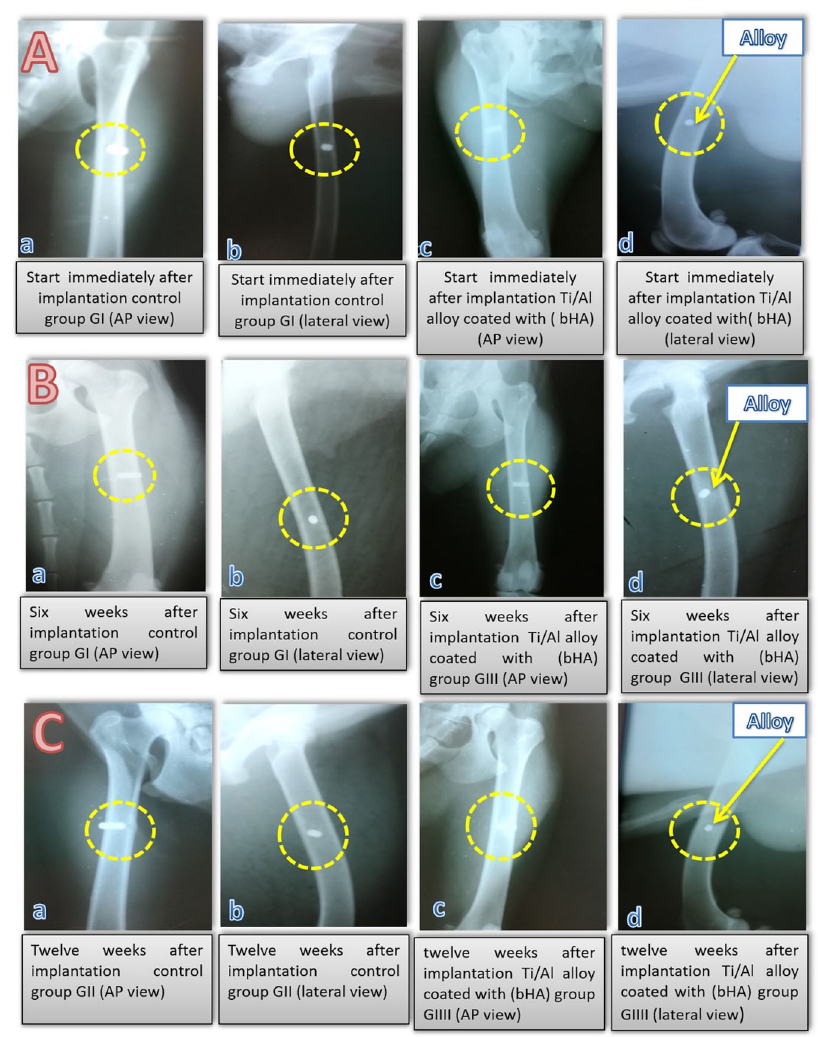
Fig. 4 This fi gure is the radiographic images for: A Control Group (un- coated) and b-HA coated Group (treated) for all four groups (in both the AP and lateral view) immediately after implantation, at zero time (T0). B Control Group I and treated Group III (in both AP and lateral view) after 6 weeks. Group IV (in both AP and lateral view) after 12